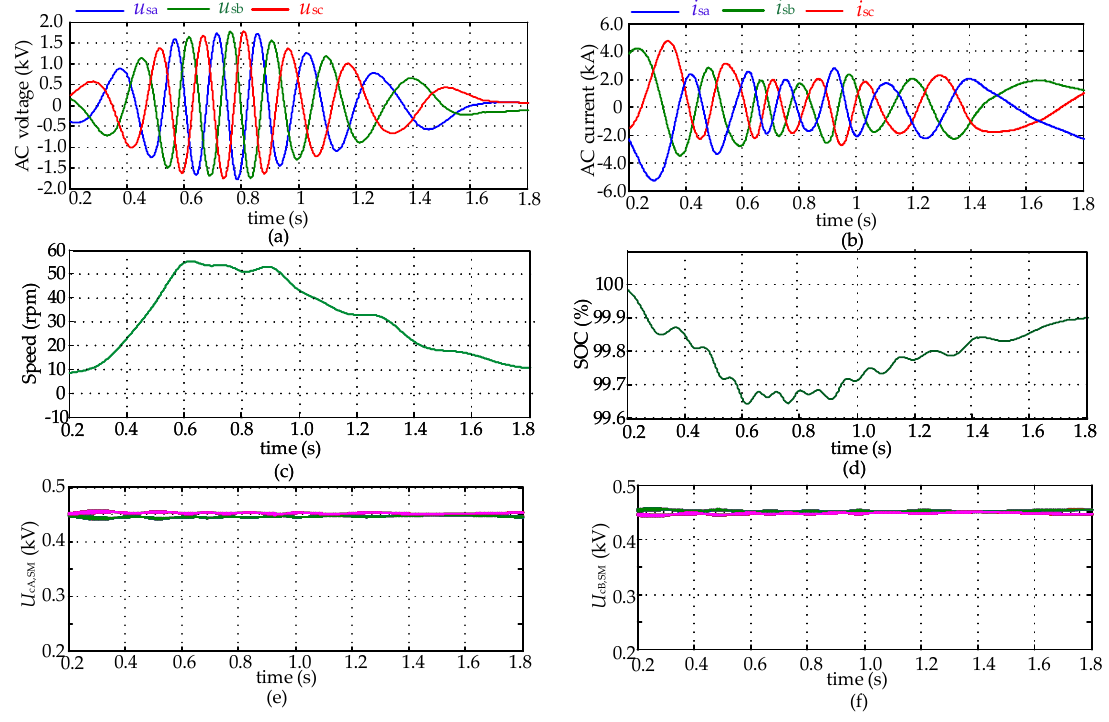
Figure 7. Configuration of SCES-MMC simulation model.